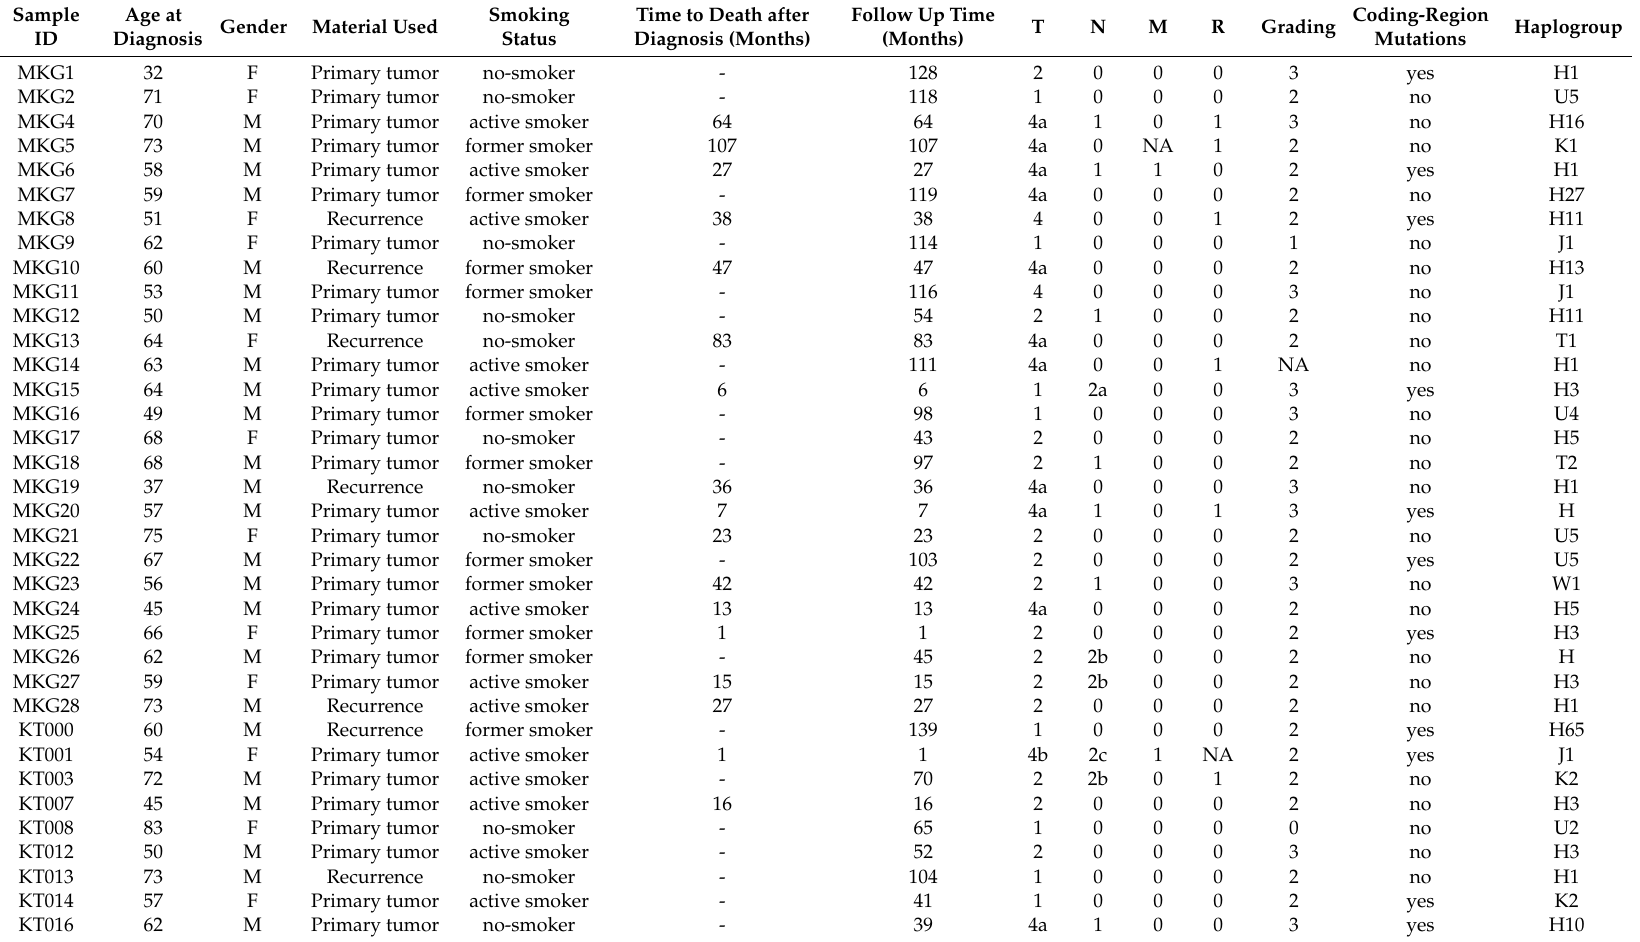
Table 1. Patient characteristics. Females represented 33.3% of the study group. A total of 81% of the material was collected from primary tumors; 38.9% of the individuals were active smokers; 38.9% of patients had a T grade of 4, 38.9% of 2, and 22.2% had a T grade of 1. 33.3% of all patients had a lymph node involvement; 5.4% presented distant